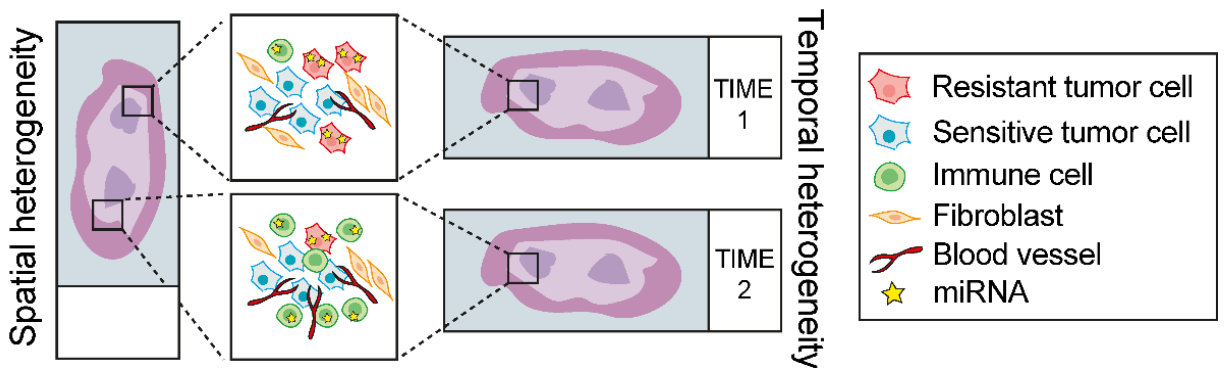
Figure 2. The problem of tumor heterogeneity in the study of miRNAs associated to therapy re- sponse. Schematic model of how spatial and/or temporal heterogeneity can affect the analysis of the association between miRNA expression and therapy response.